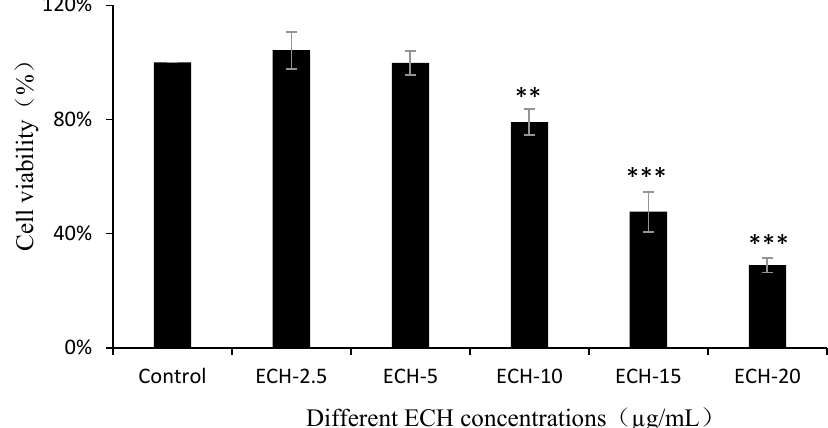
Figure 1. The effects of various concentrations of ECH on RAW 264.7 cell viability. Raw 264.7 cells were pretreated with ECH (2.5 to 20 μ g/mL) or not for 24 h, cell viability was tested using the CCK ‐ 8 method. ** ( p < 0.01) and *** ( p < 0.001) indicates significant difference compared with the control group.